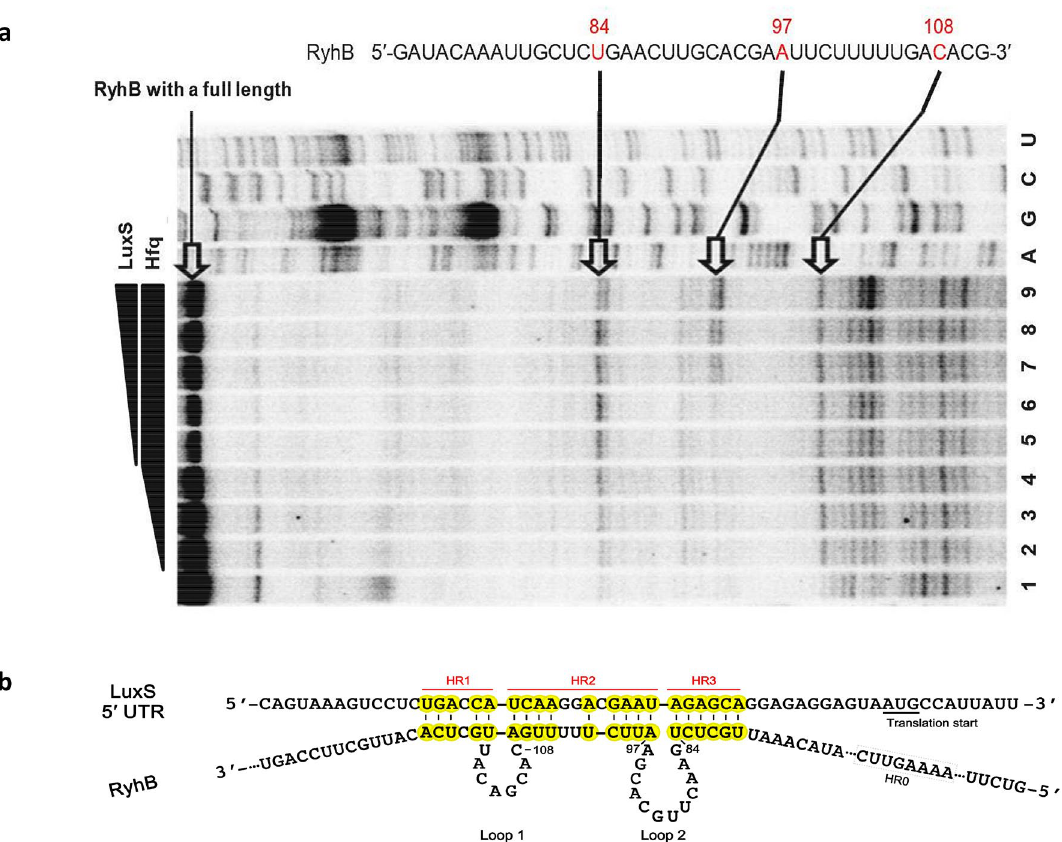
Figure 9. Identification of regions of RyhB RNA that hybridize with luxS mRNA. ( a ) Primer extension assays to determine the hybridization sites between RyhB and luxS RNA. Lanes 1 to 4 include Hfq at 0, 125, 250, and 500 nM, respectively. Lanes 5 to 9 include luxS RNA at 100, 200, 400, 600, and 800 nM incubated with 1 μM Hfq, respectively. The three distinct bands that represent higher intensities in the presence of Hfq are indicated. Base positions are numbered relative to the transcription start site of RyhB. ( b ) A model of base pairings between LuxS 5 ′ -UTR and RyhB. Hybridization regions (HR) 1, 2, and 3 are highlighted in yellow. Loops 1 and 2 of RyhB, which form during the hybridization also are indicated. The region labeled HR0 is the site that was mutagenized to generate HR0m as a positive